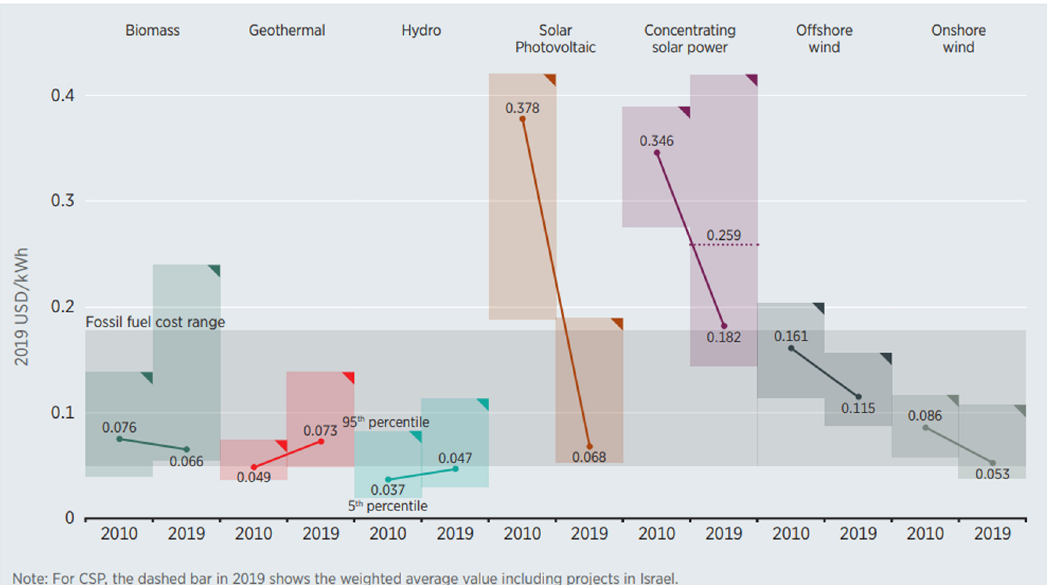
Figure 23: LCOE for electricity generation of some renewable technologies, from 2010 to 2019. ( Retrieved from: IRENA ( 2020 ) , Renewable Power Generation Costs in 2019, International Renewable Energy Agency, Abu Dhabi. [ 157 ] . )